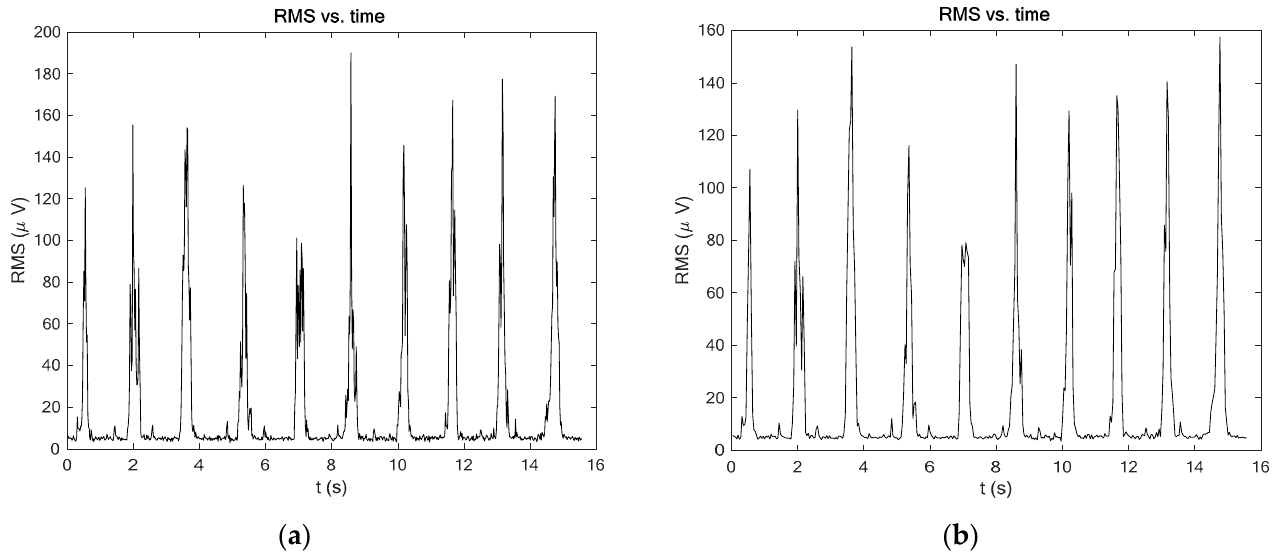
Figure 17. RMS-EMG signal of the right abdominal muscle with high content of power line parasitic disturbances, HP Butterworth filter ( f c = 20 Hz), ( a ) 40/40 (length/offset), ( b ) 80/80